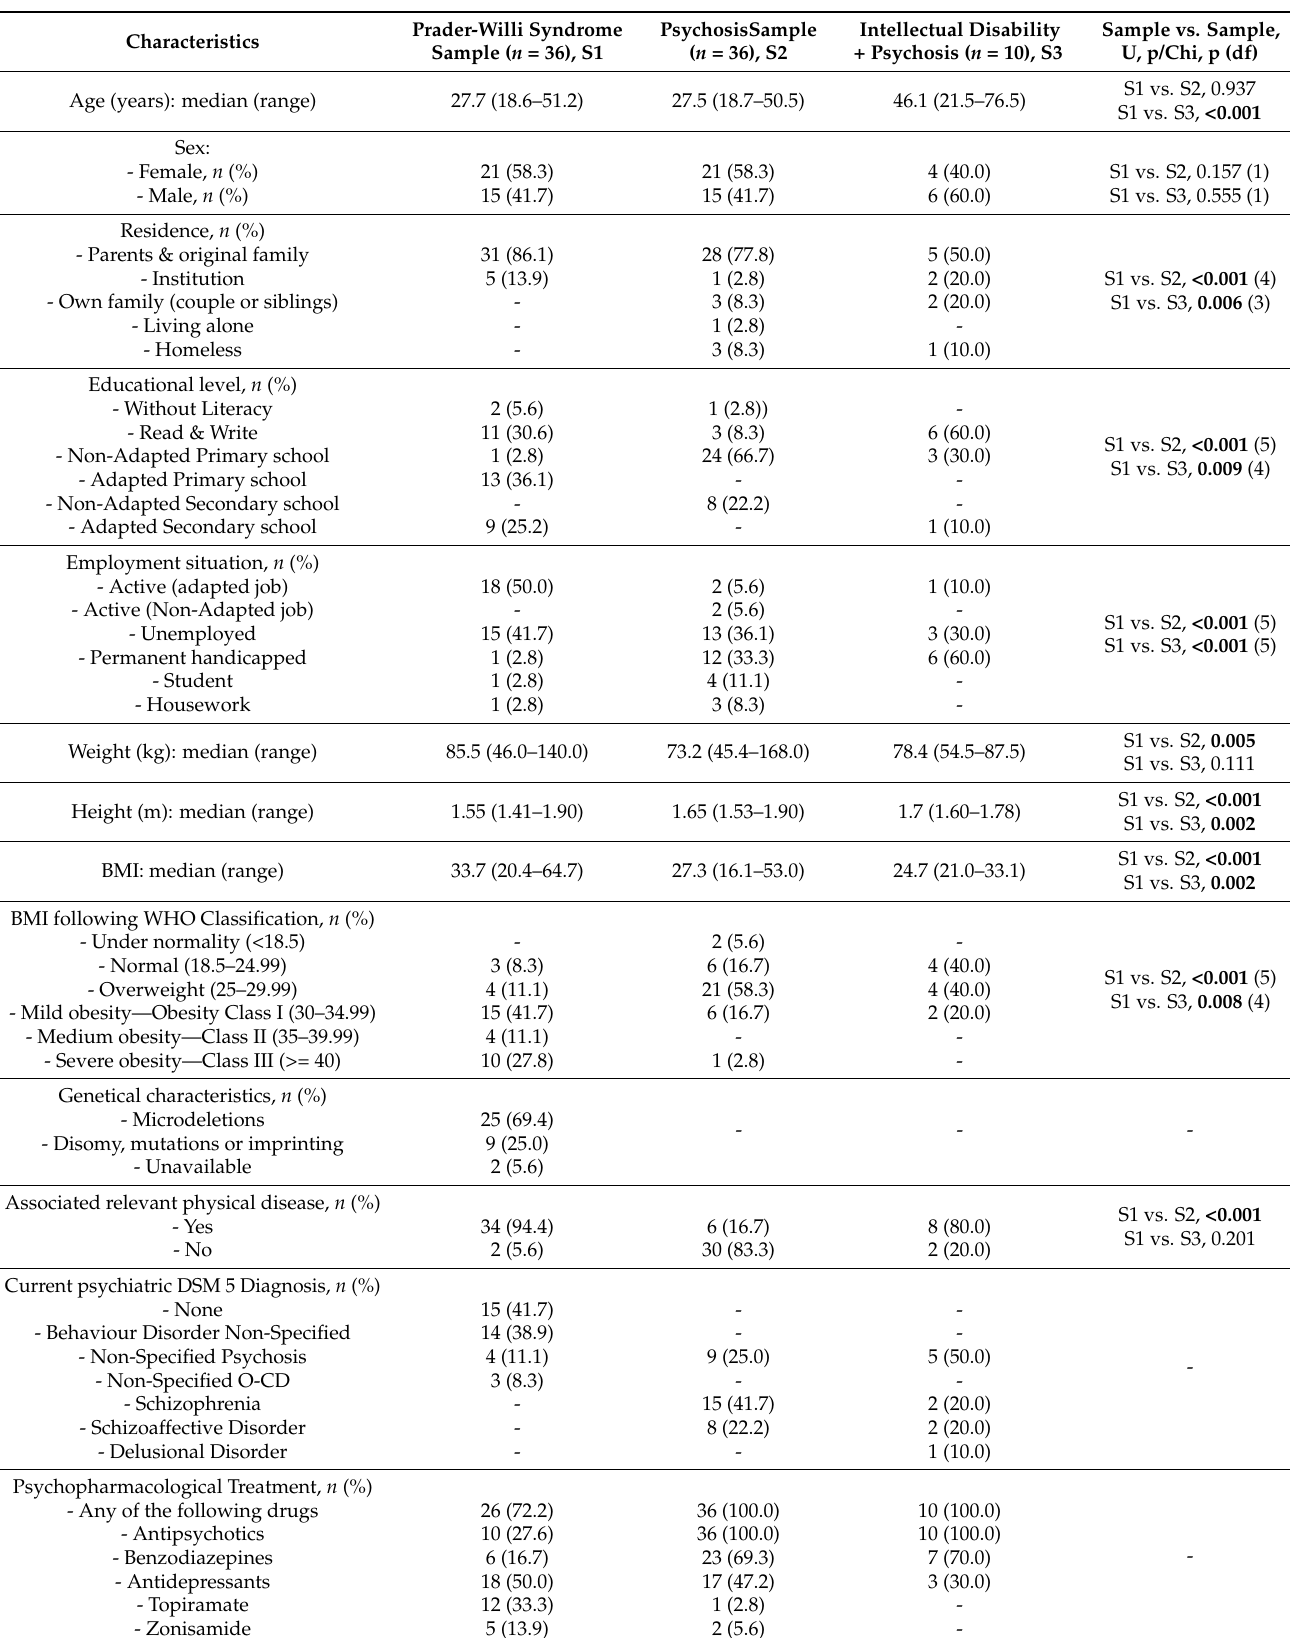
Table 1. Sociodemographic, clinical, and psychometric description of the samples.